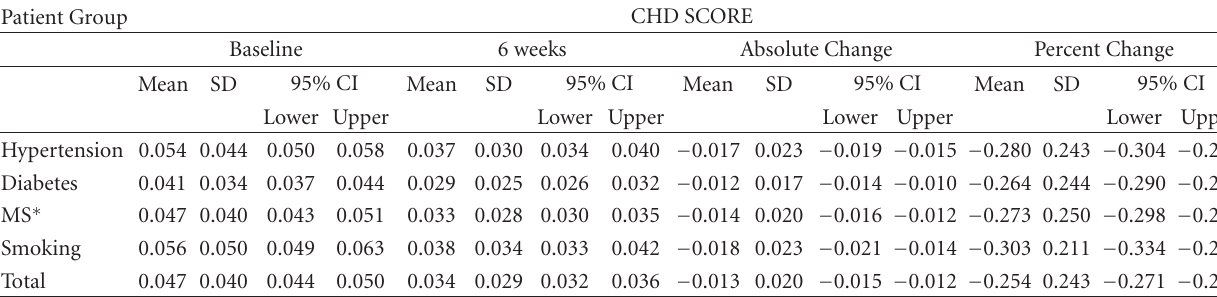
Table 2: CHD SCORE at baseline and final (6-week) assessments.